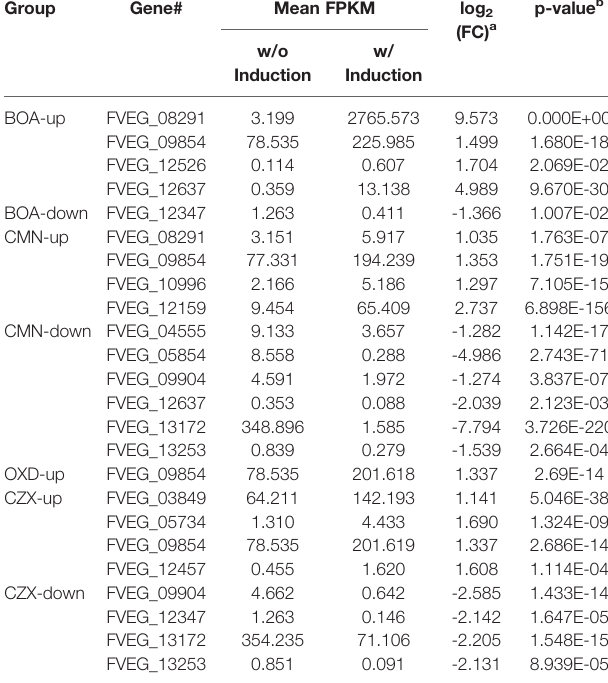
TABLE 8 | Lactamase genes differentially expressed upon exposure to BOA, CMN, OXD, and CZX. Group